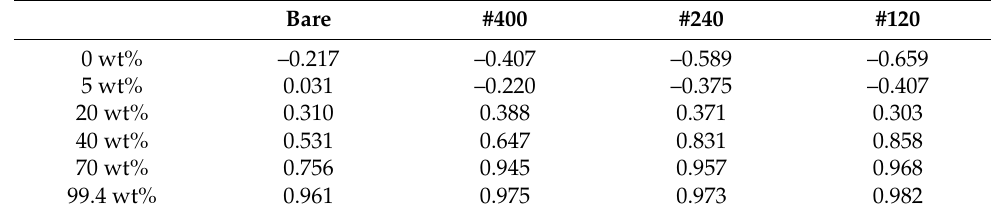
Figure 7. Relationship between 1 + cos θ ave and the mass concentration of ethanol: ( a ) bare substrate; ( b ) #400 substrate; ( c ) #240 substrate; and ( d ) #120 substrate. The error indicates two standard deviation (2SD). Table 3. Values for cos θ ave in each solid